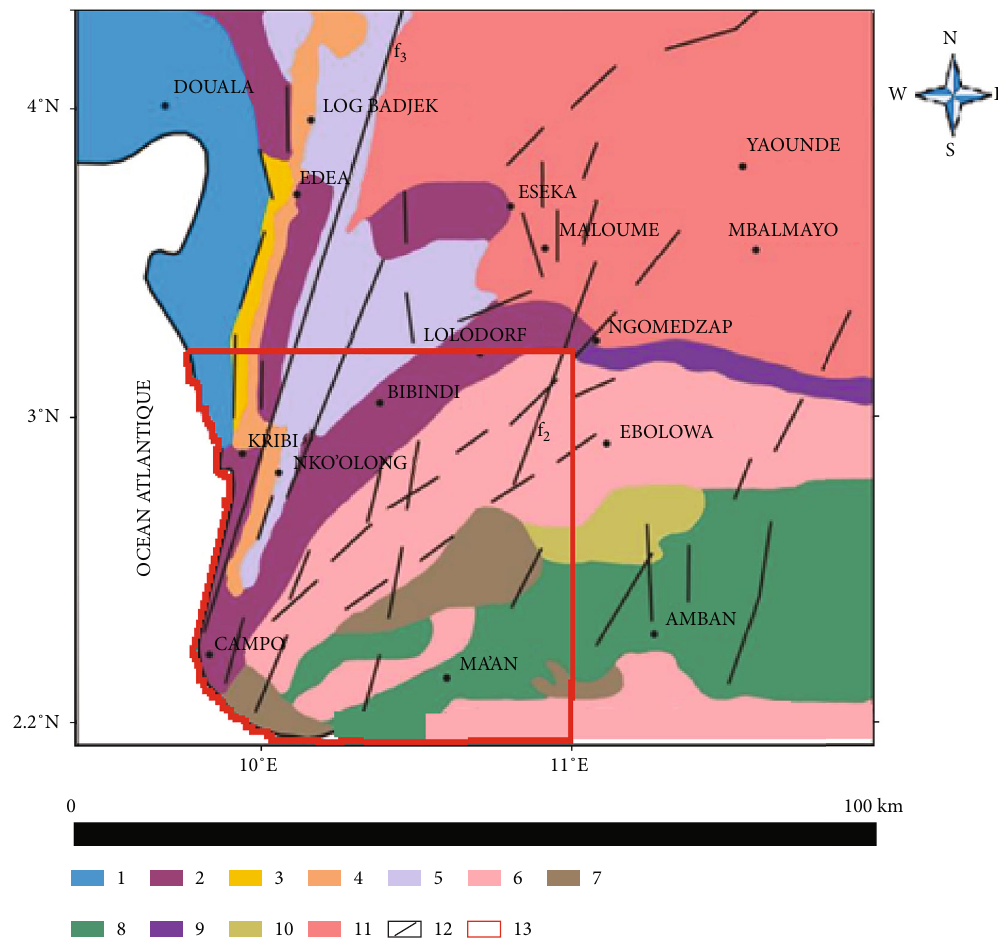
Figure 2: Geological map of the study area (Southwest Cameroon) from [10]. Cameroon Atlantic coast basins, 1: sediments. Nyong unit, 2: gneiss; 3: metagranodiorite; 4: metamorphic rocks of the Yaoundé group; and 5: green rock belt. Ntem unit, 6: charnockites; 7: green rock belt; 8: striped series; 9: tonalites; and 10: potassic granitoïdes. Yaoundé group, 11: undi ff erentiated metamorphic unit of the North Equatorial Pan-African belt. 12: faults f1 and f2: deep gravimetric faults [26]. F3: Kribi-Campo fault. 13: study